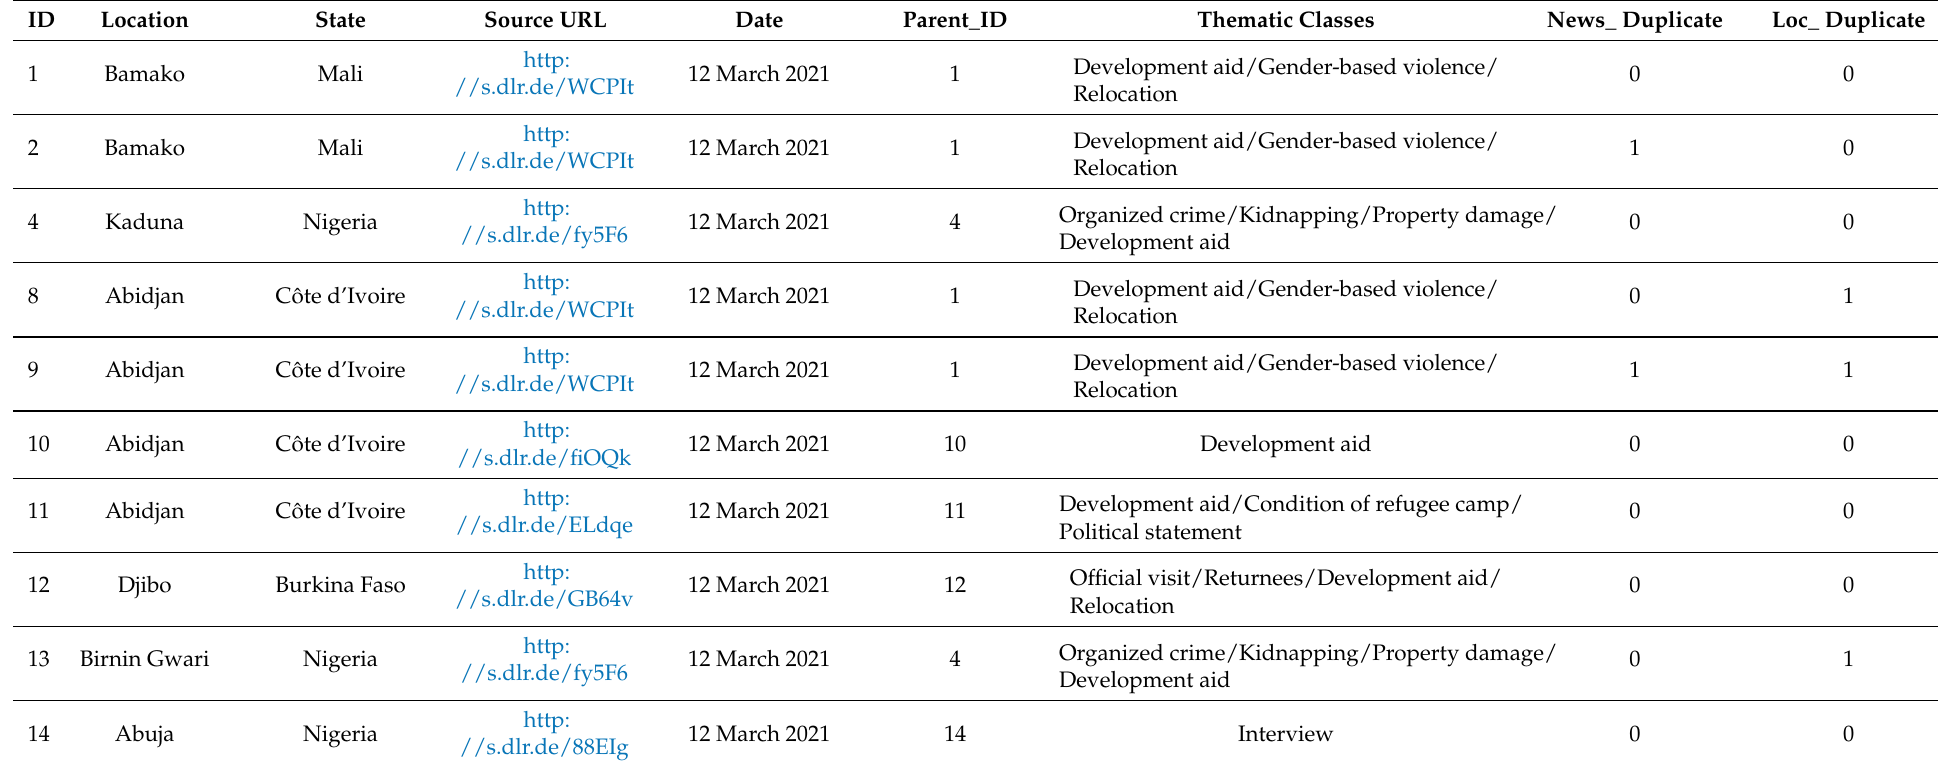
Table 3. An excerpt of the WARRe